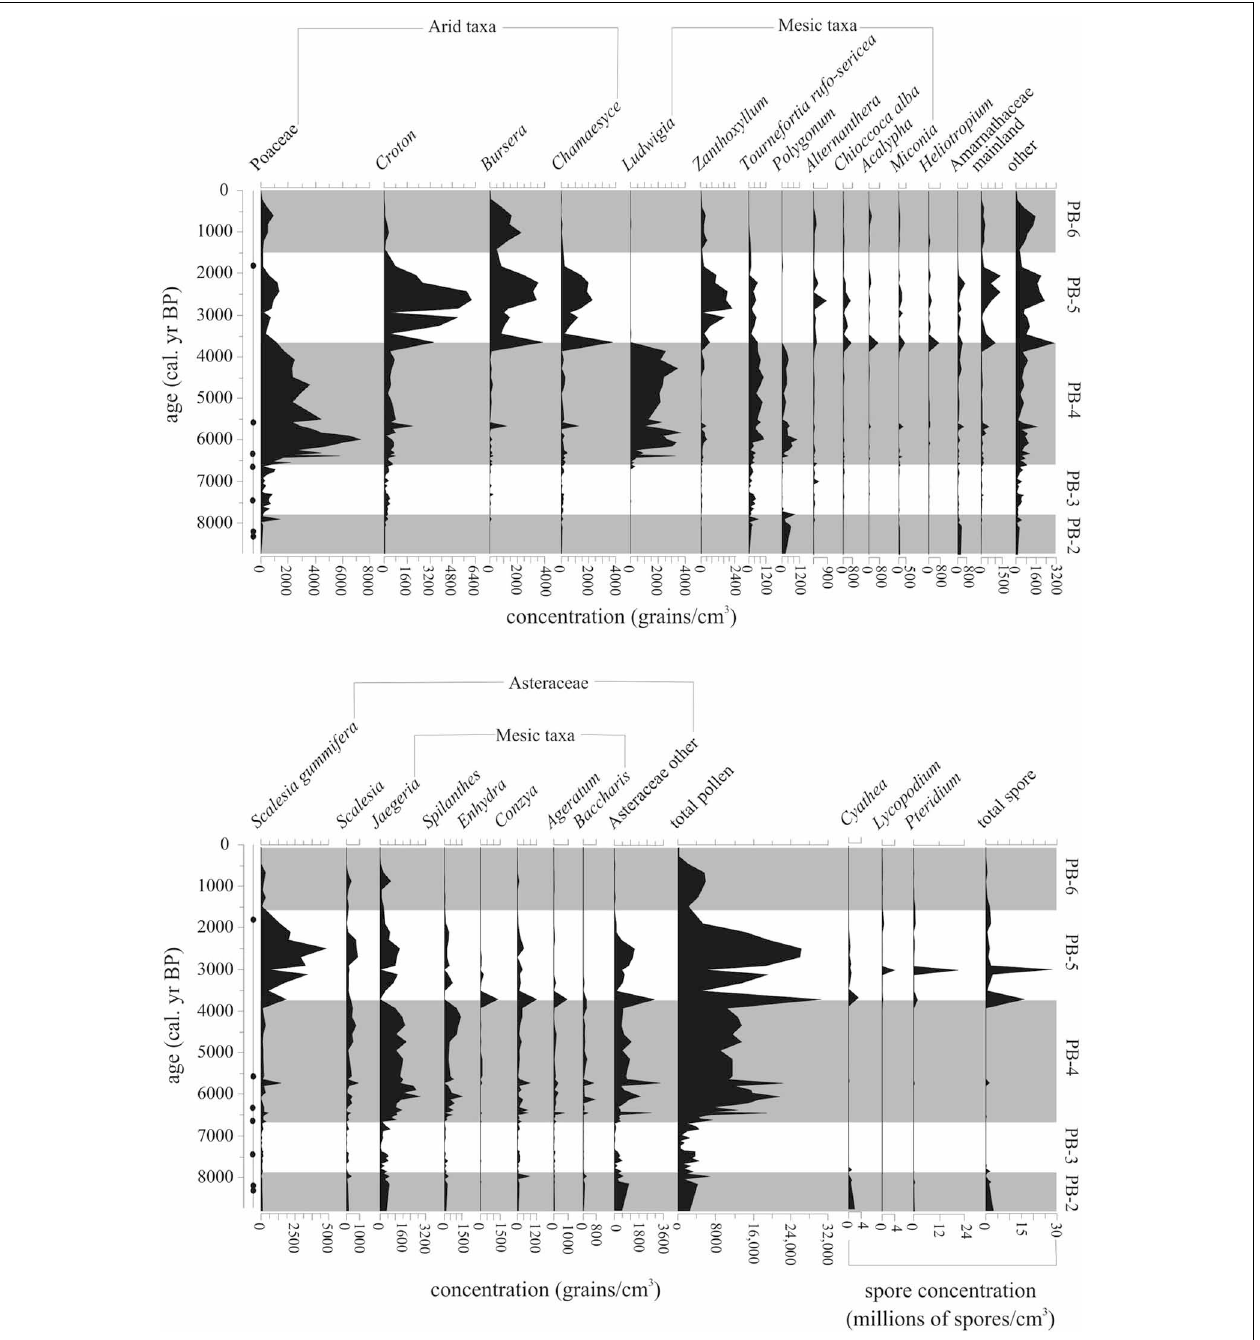
FIGURE 6 | Pollen concentration (grains/cm 3 ) of the 25 most common taxa within the Holocene-aged samples (8740-0 cal. year BP) from Paul’s Bog. Local pollen zones are shown. Radiocarbon date locations (solid circles) on right of age axis.